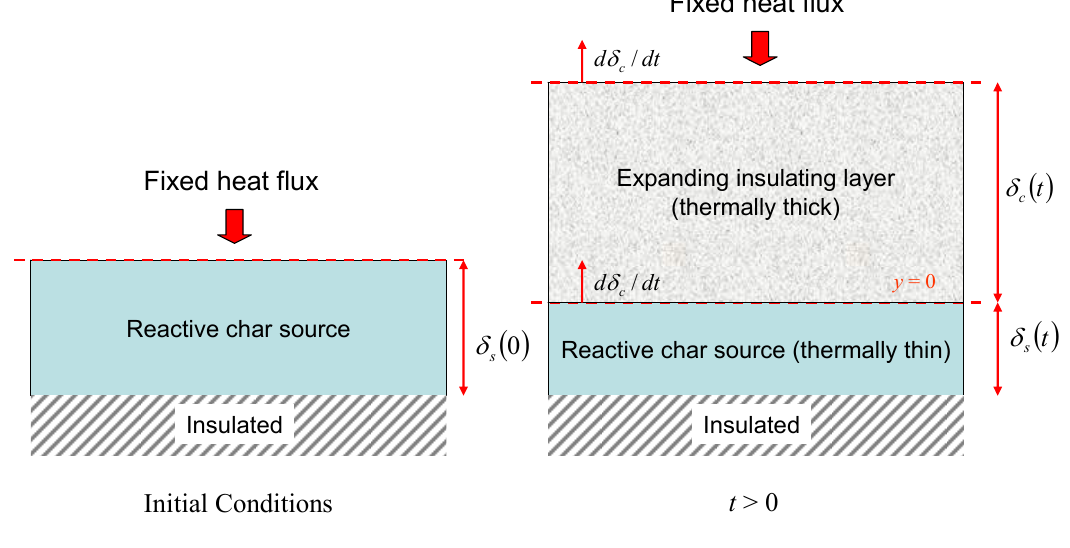
Figure 7. Illustration of simple expanding char